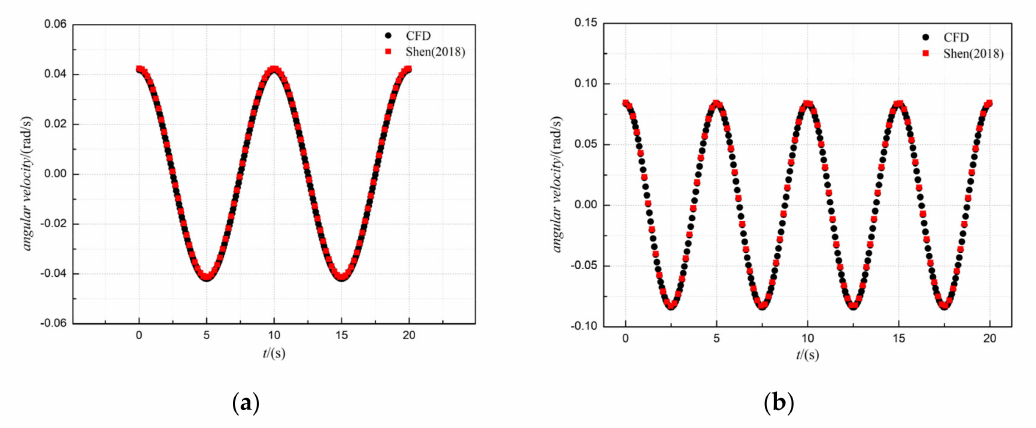
Figure 4. Angular velocity characteristics of dynamic motion, ( a ) f = 0.1 Hz; ( b ) f = 0.2